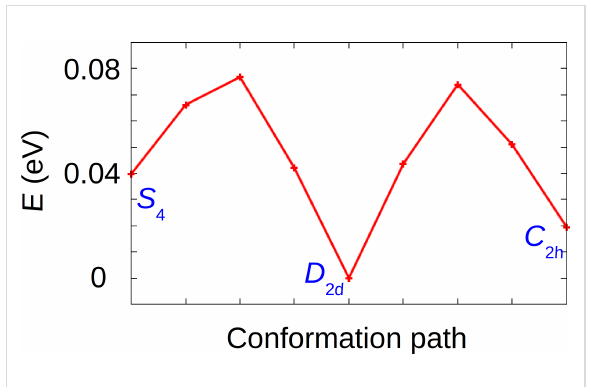
Figure 2: Activation energy to pass from the twist form ( S 4 ) to the saddle shape ( D 2 d ) and from the saddle shape to the deckchair confor- mation ( C 2 h